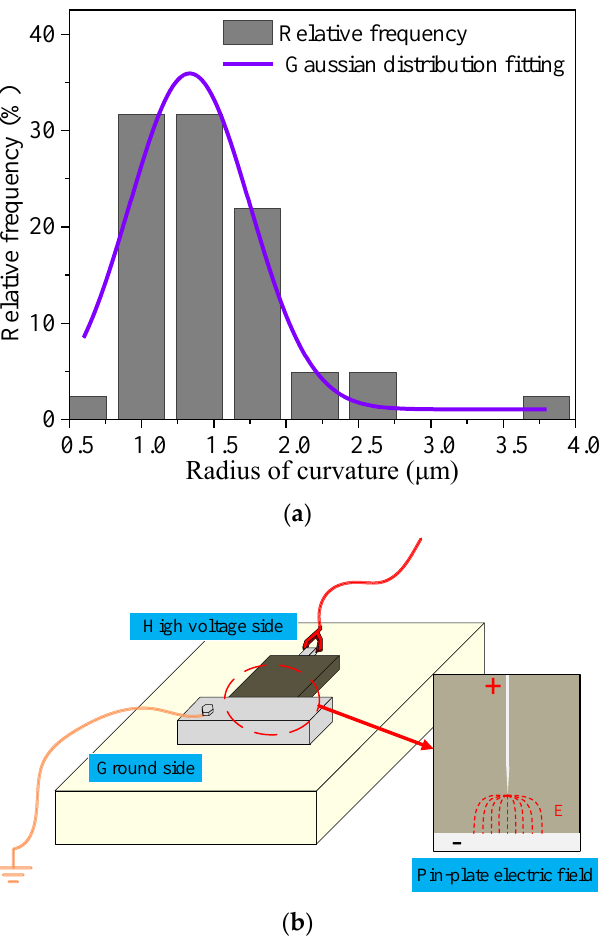
Figure 4. ( a ) Radius distribution of needle tip curvature; ( b ) Pressurization of PD samples.